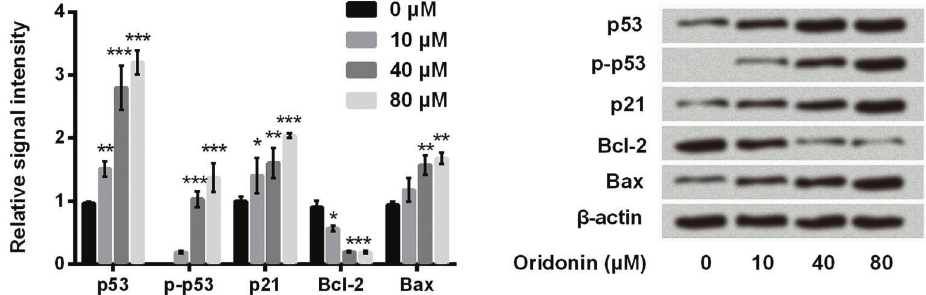
Figure 5. Oridonin enhanced the functions of p53 in SNU-216 cells. SNU-216 cells were incubated with oridonin (0, 10, 40, and 80 m M) for 24 h. Then, the protein levels of p53, p-p53, p21, Bcl-2, and Bax were detected by western blot. Data are reported as means ± SD. *P o 0.05, **P o 0.01, ***P o 0.001 compared to 0 m M